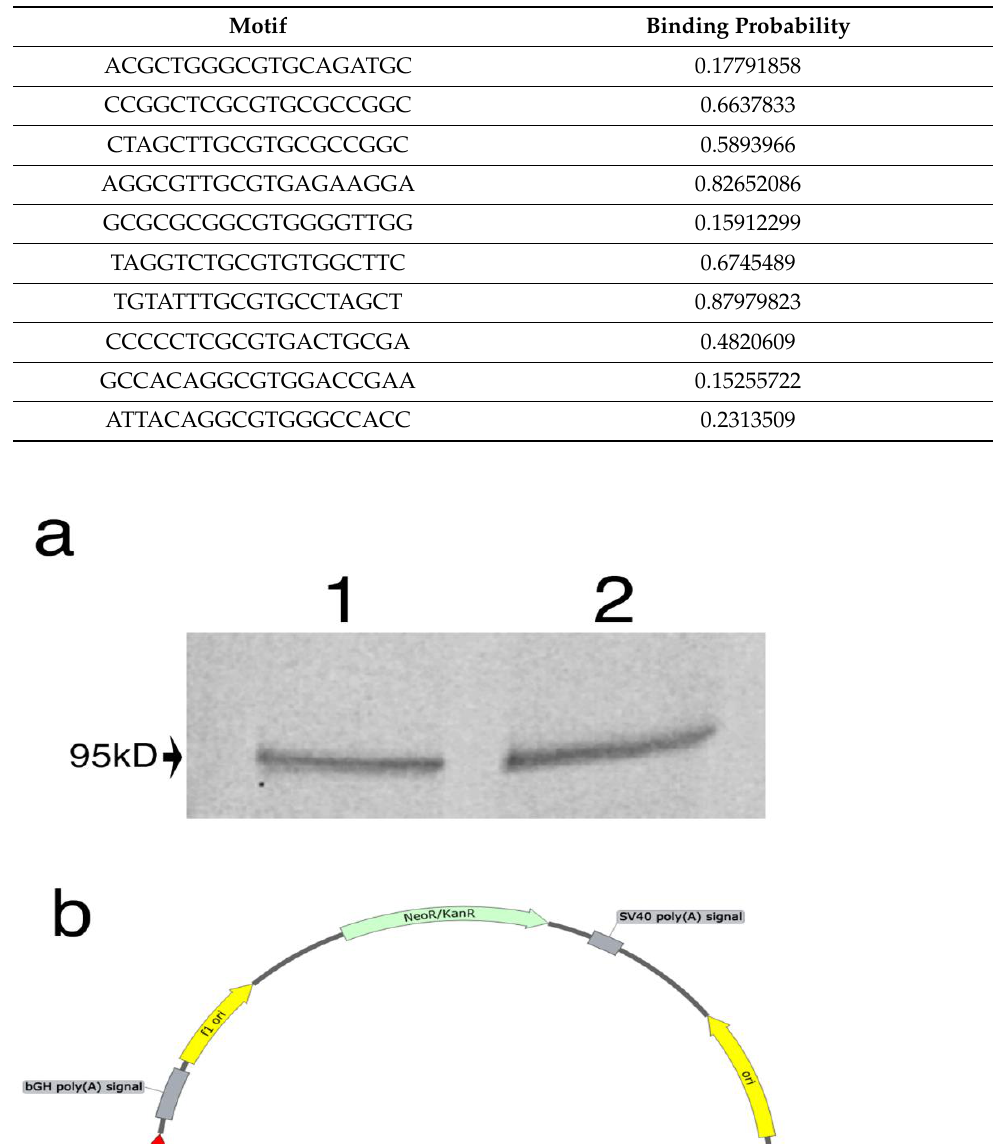
Table 1. Ten putative AHR/aryl hydrocarbon receptor nucleus translocator (ARNT) binding sites and their corresponding binding probabilities.